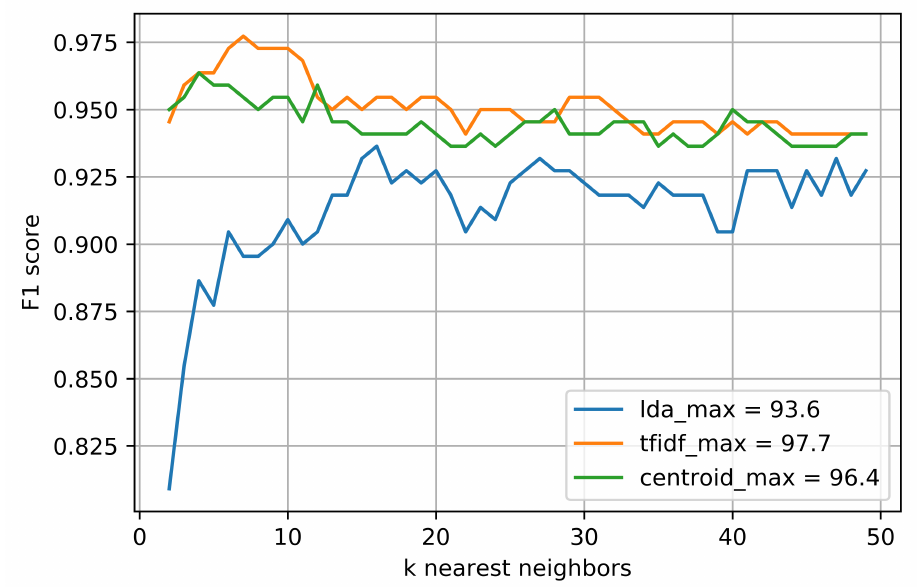
Figure 4. Comparison of weighting methods’ F1 scores in k -NN task for BBC